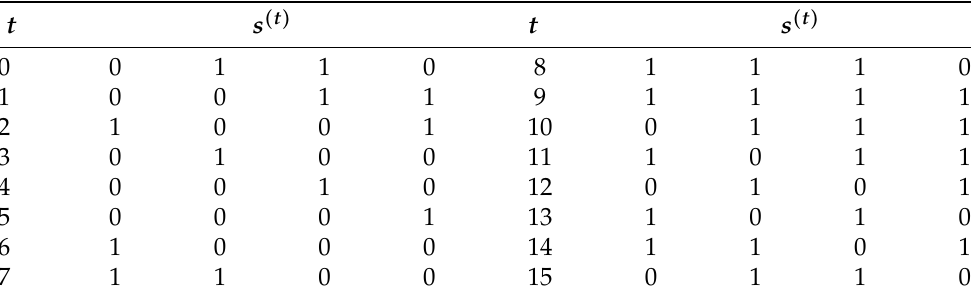
Table 1. Values of the Linear Feedback Shift Register (LFSR) (cid:104) 4,1 + x + x 4 (cid:105) whose initial state